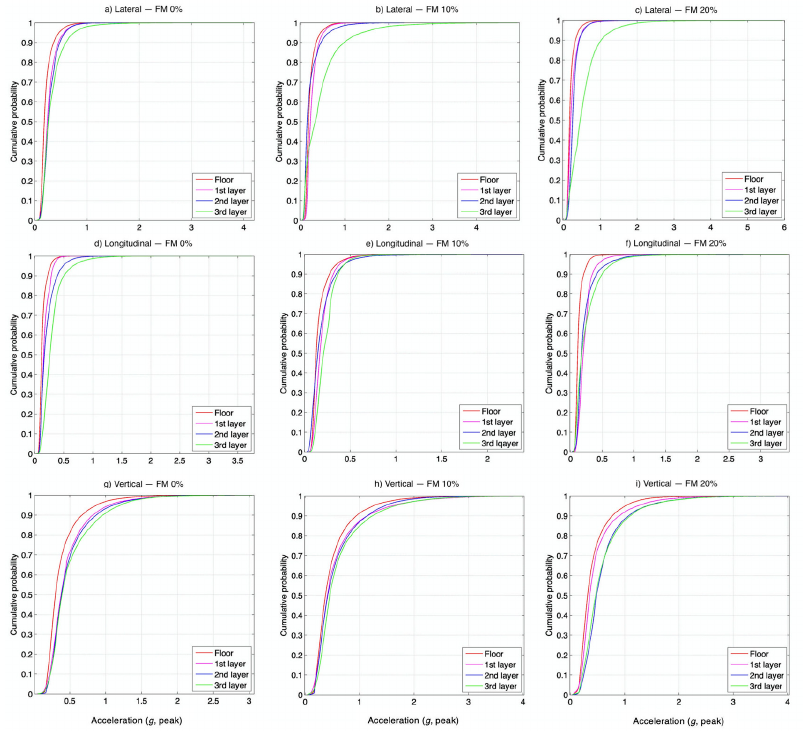
Figure 5. Empirical cumulative distribution functions (CDFs) of peak acceleration values: ( a – c ) lateral direction with FM 0%, 10%, 20%; ( d – f ) longitudinal direction with FM 0%, 10%, 20%; ( g – i ) vertical direction with FM 0%, 10%,